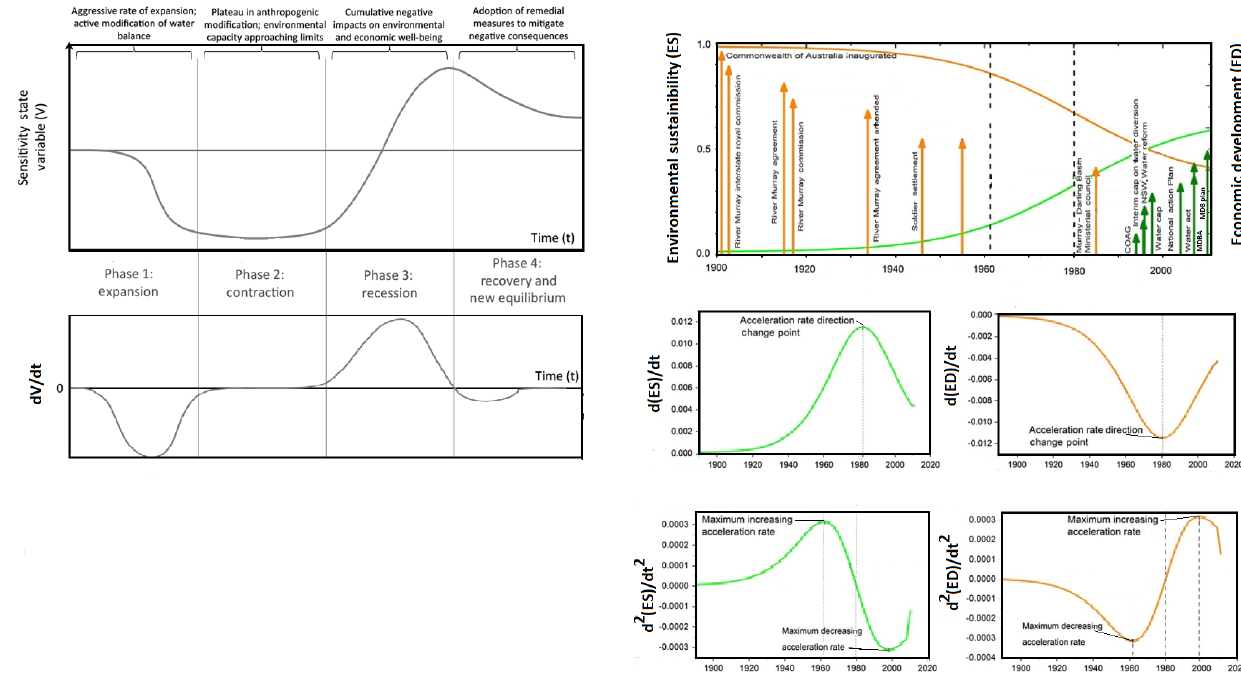
Figure 4. Defining shifts and turning points of stages of societal values.